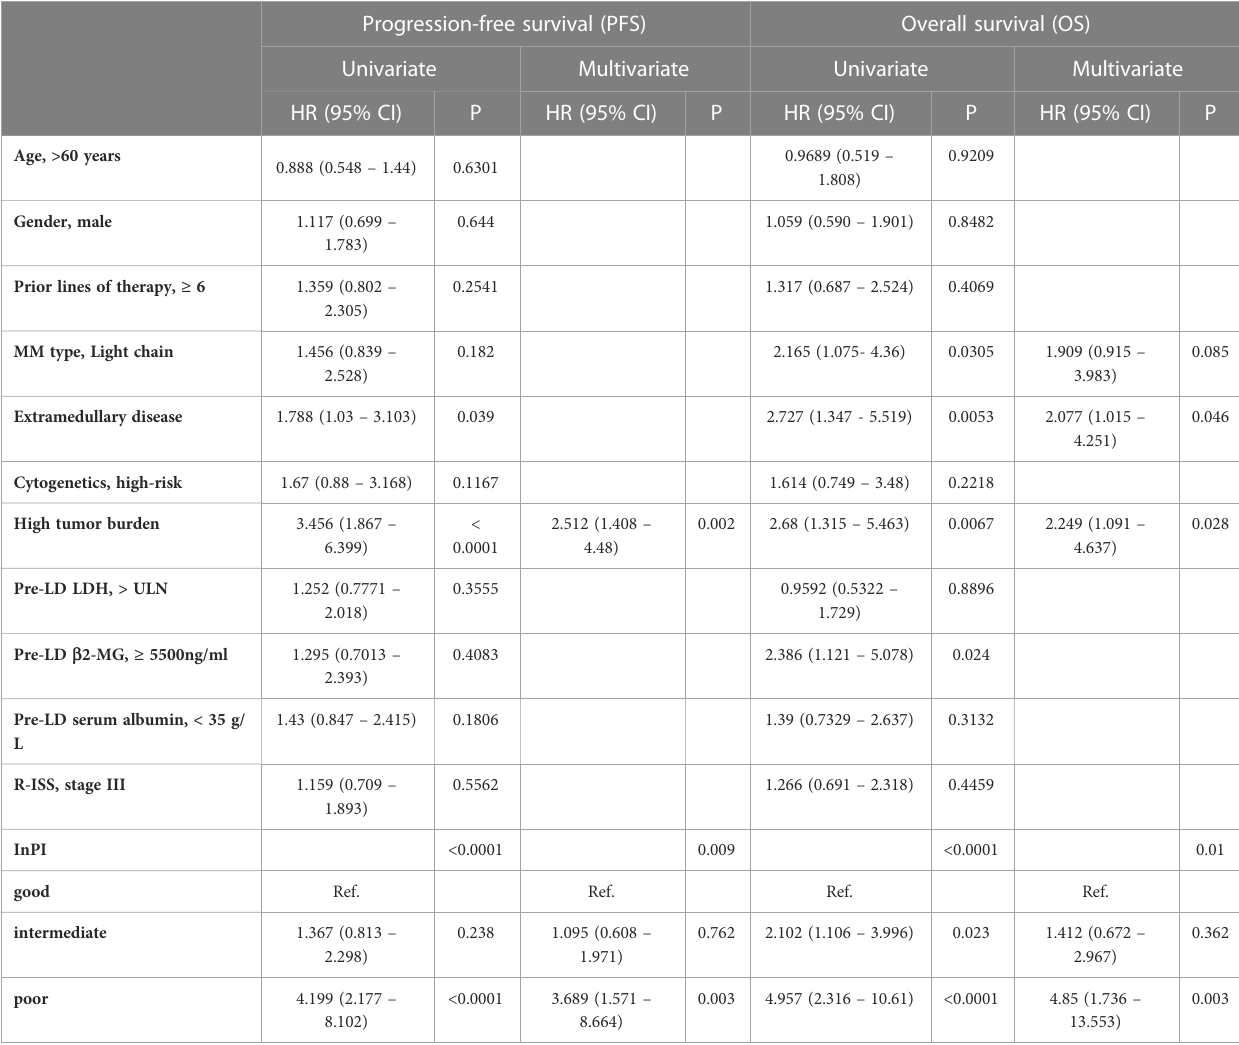
TABLE 2 Univariate and multivariate analysis of PFS and OS.